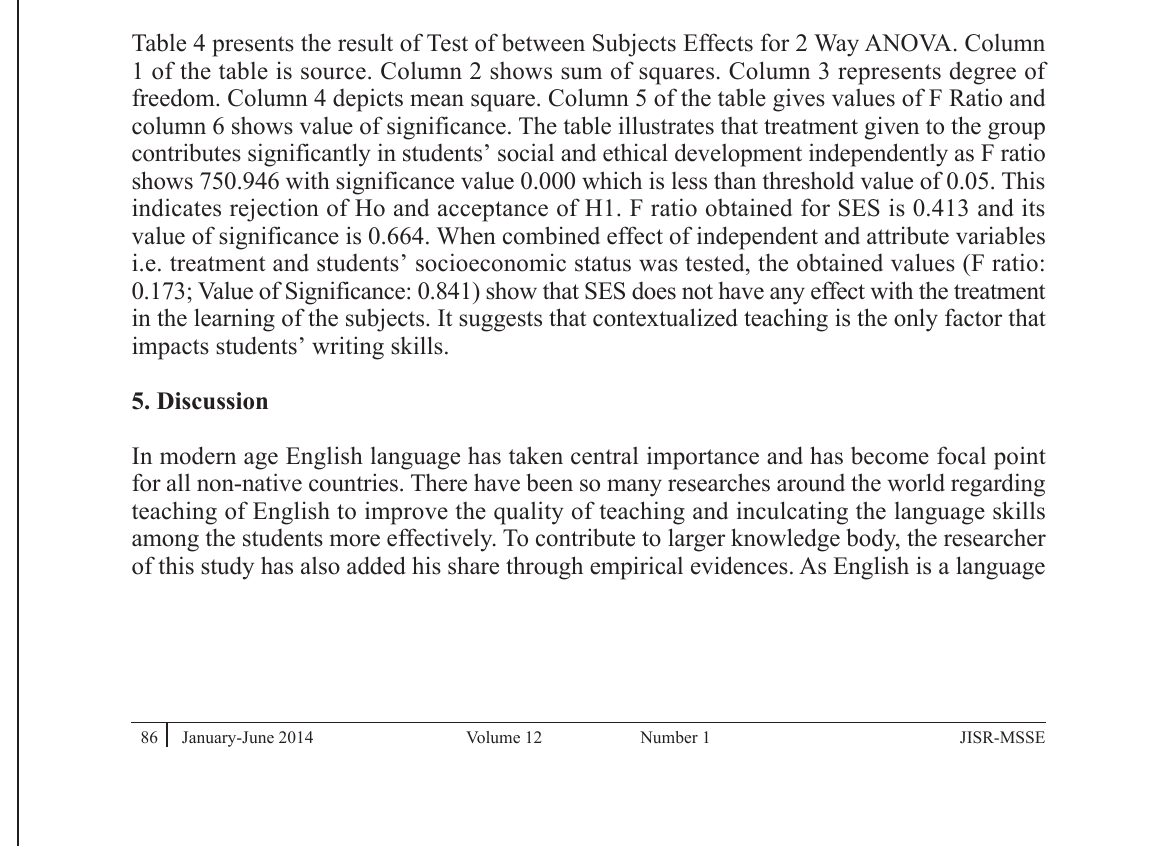
df 5 1 1 2 2 66 72 71